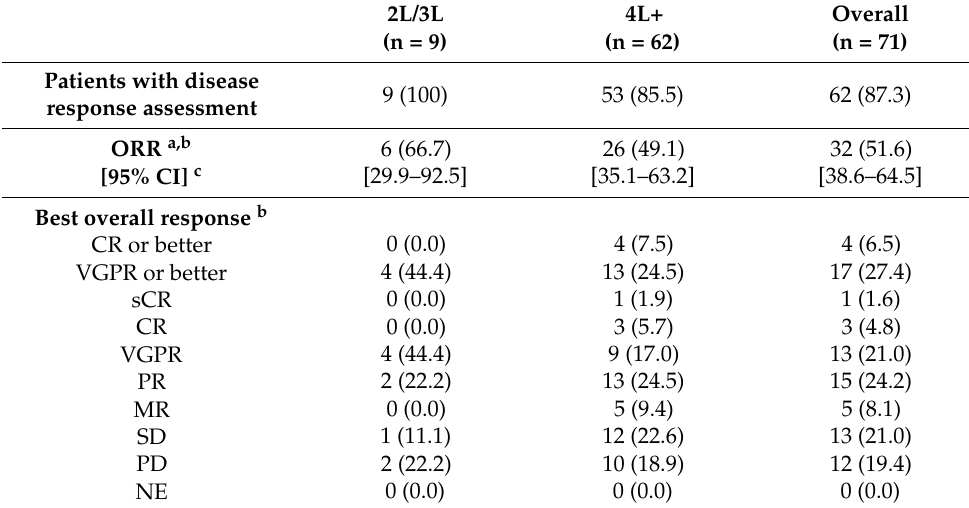
Table 4. Treatment response for patients with anti-CD38 mAb-refractory